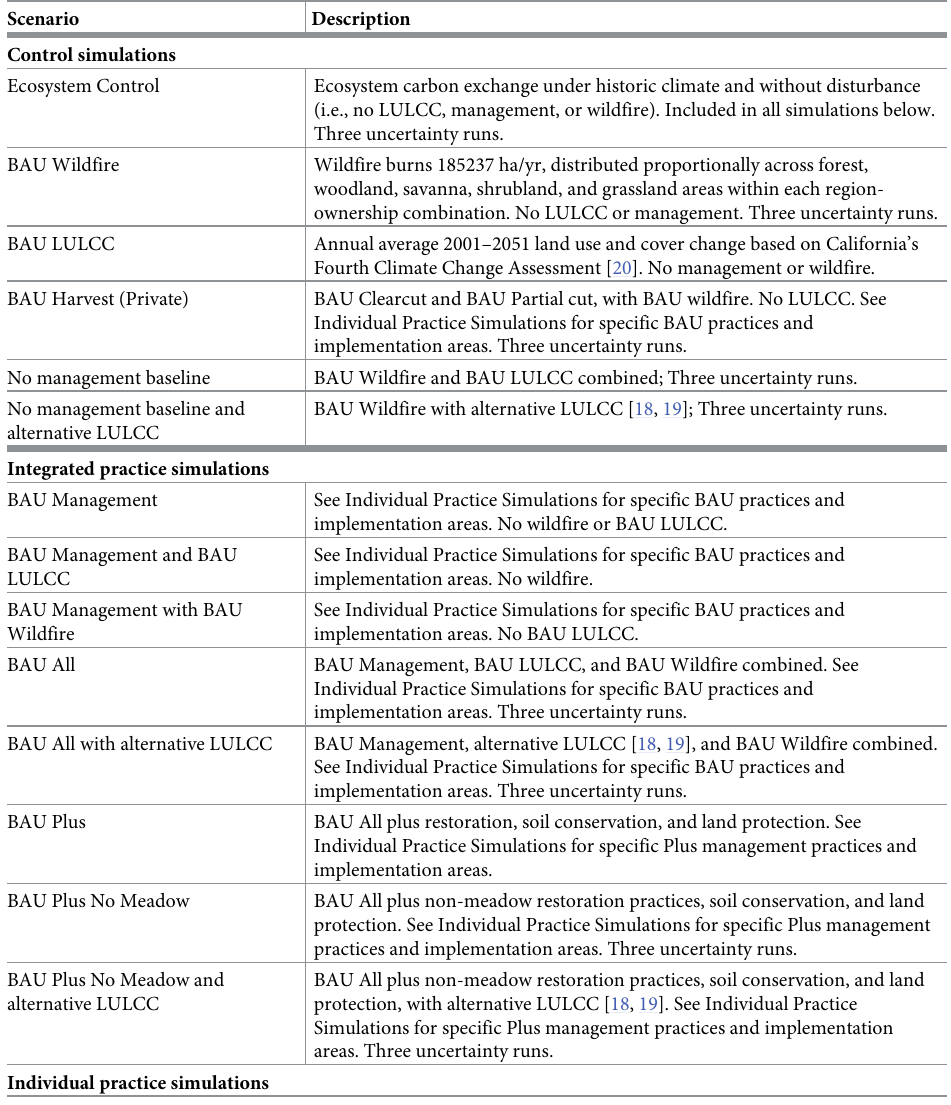
Table 3. Prescribed scenarios for CALAND